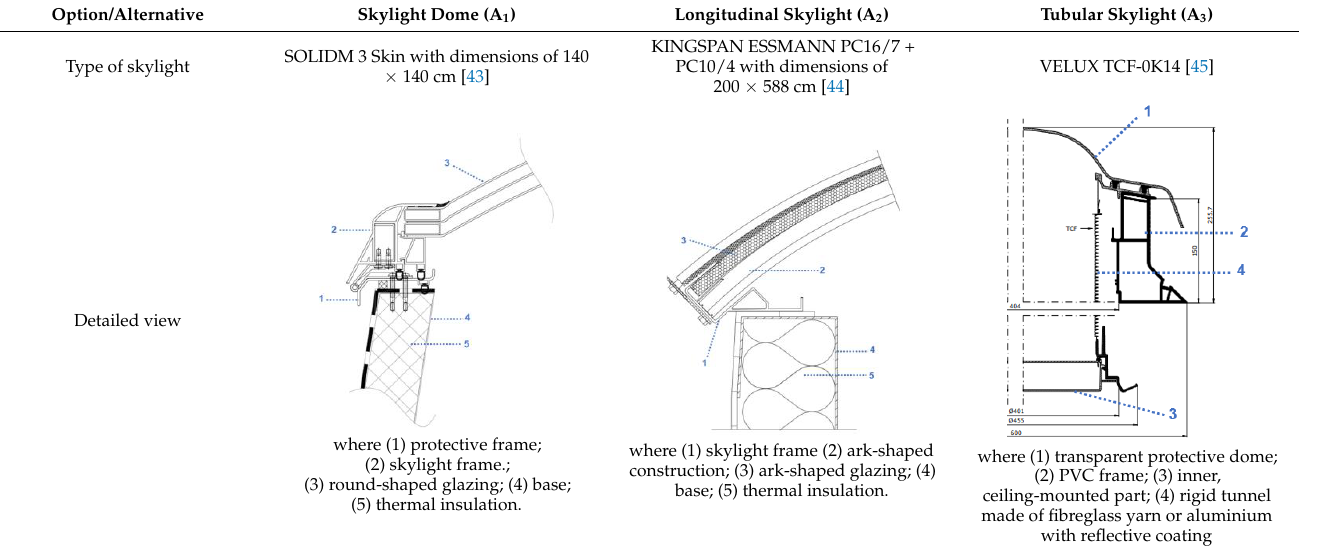
Table 2. The detailed view and some technical data of the selected skylight alternatives.